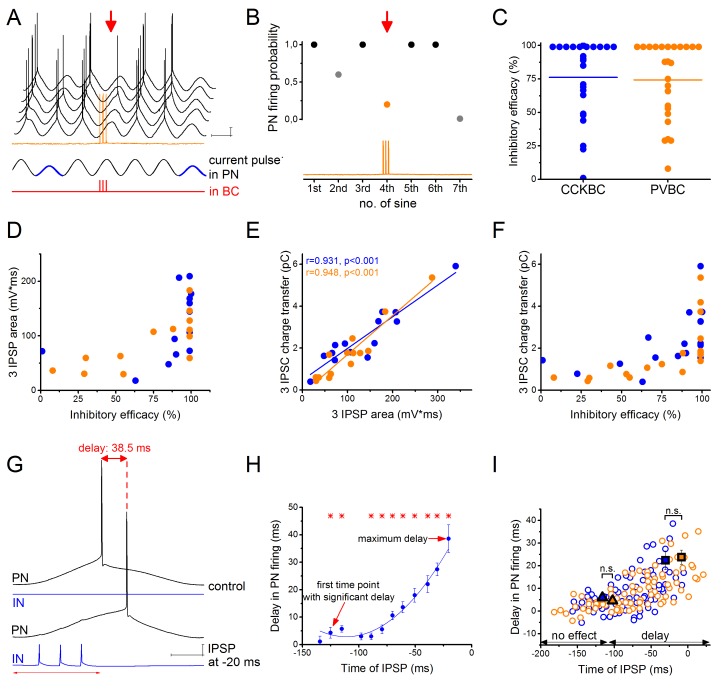
CCKBCs and PVBCs inhibit PN firing with similar efficacy.(A) Representative experiment for testing the capability of a BC to control spike generation in a PN. Sinusoidal current trains were injected into a PN at a theta frequency (3.53 Hz) to initiate firing and three action potentials were evoked at 30 Hz in the presynaptic PVBC 30–40 ms before the peak of the fourth cycle (for details see Materials and methods). Red arrow points to the cycle, when the presynaptic BC was stimulated. Voltage traces are offset for clarity. (B) Summary data of experiments shown in panel A: the firing probability of the PN was significantly suppressed within the cycle when the action potential train was evoked in the presynaptic PVBC. (C) Comparison of the inhibitory efficacy of CCKBCs and PVBCs. The inhibitory efficacy shows the probability of the suppression of action potential generation in the PN by BC firing (i.e.: 1- [PN firing probability during the control sinusoidal current cycles - firing probability when the BC is stimulated]) CCKBC: 76.2 ± 7.1%, n = 25, PVBC: 75.6 ± 6.5%, n = 25, p=0.88, M-W test. (D) The relationship between the inhibitory efficacy and the area of IPSPs. (E) The area of the IPSPs and the charge transfer of the IPSCs are strongly correlated. (F) The relationship between the inhibitory efficacy and IPSC charge transfer, indicating a larger inhibitory efficacy at a larger charge transfer. (G) Representative experiment for testing BCs ability to postpone PN firing. The timing of the evoked action potential in a BC was systematically shifted relative to the peak of the sinusoidal current injected into the PN. (H) The delay in PN firing as a function of the timing of synaptic inhibition in the pair shown in G. Asterisks indicate significant delay in firing compared to the peak of the cycle during the control period (paired sample Wilcoxon signed rank test p<0.05). (I) Pooled data from 7 CCKBC and 6 PVBC pairs. Squares show the average maximal delay (CCKBC: 22.40 ± 4.14 ms, n = 7, PVBC: 23.76 ± 3.16 ms, n = 6, p=0.72, M-W test) and triangles show the average last time point with significant delay in PN firing (CCKBC: −116.21 ± 14.47 ms, PVBC: −102.41 ± 18.58 ms, p=0.94, M-W test). Color codes are the same as in panel C (blue: CCKBCs, orange: PVBCs). Scales: A: 10 mV, 200 ms; G: 10 mV, 50 ms.